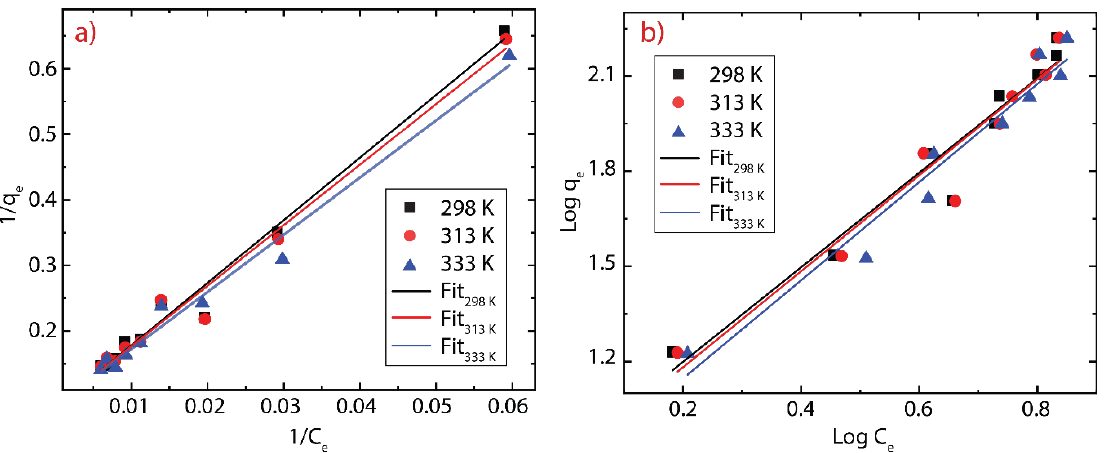
Figure 6. Adsorption isotherm of MB on rGO at different temperatures. ( a ) Langmuir model and ( b ) Freundlich model. Table 3. Parameters of Langmuir and Freundlich isotherm adsorption model, considering different temperatures.